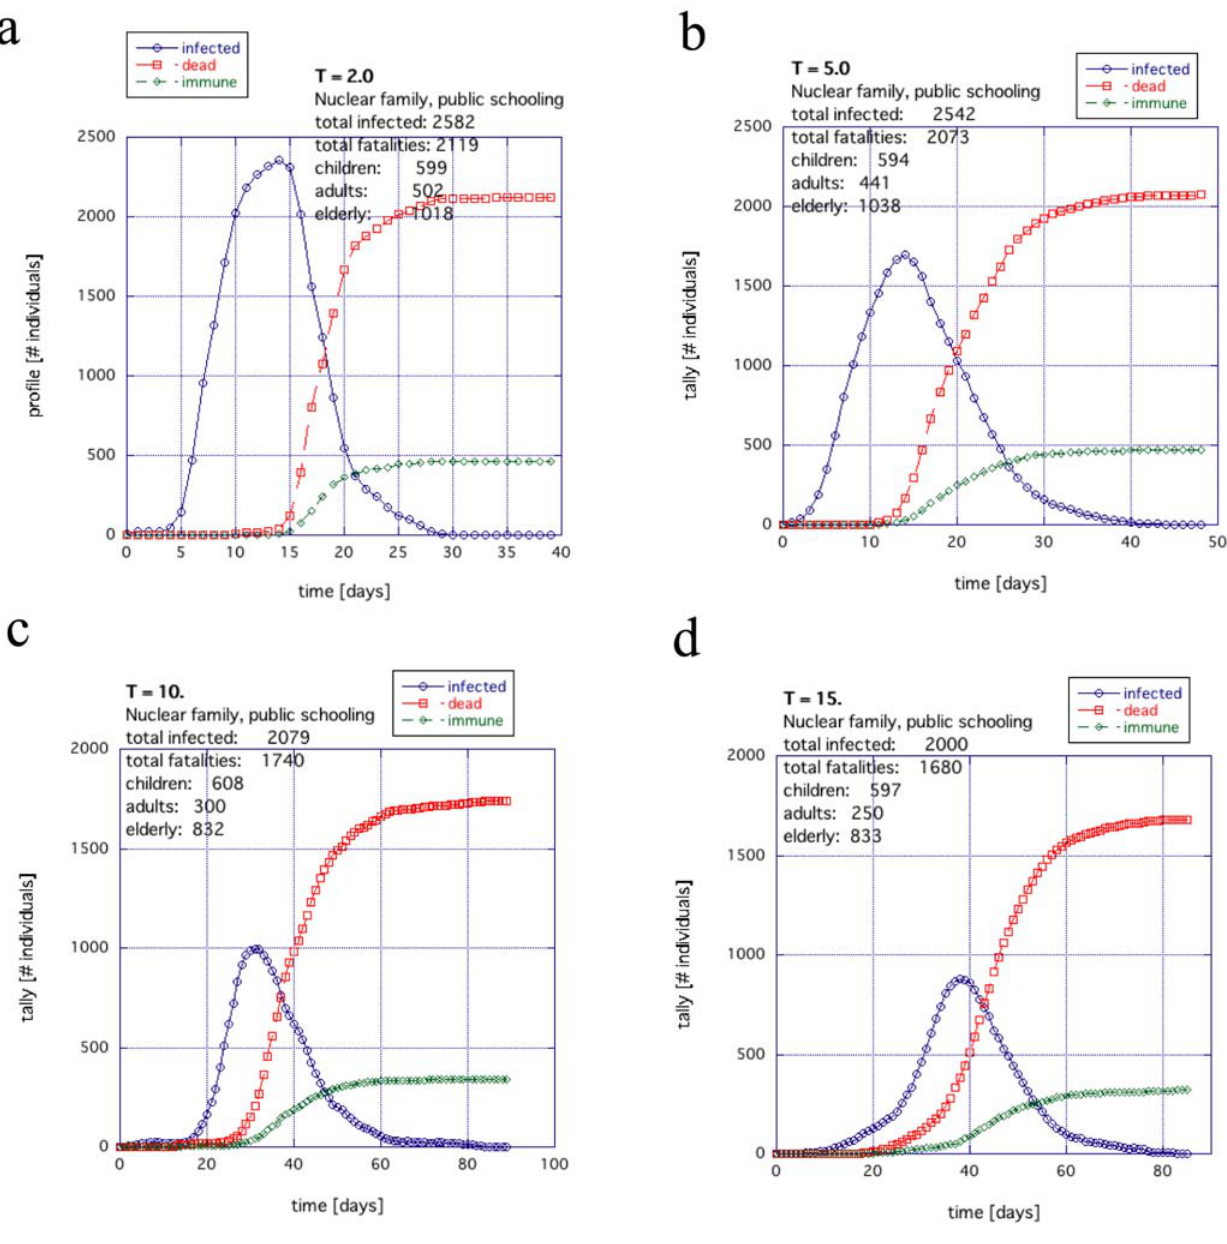
Figure 11. General trend of a nuclear family society when the children are home schooled as a function of temperature; (a) T ~ 2 : 0 , (b) 5.0, (c) 10.0, (d) 15.0.